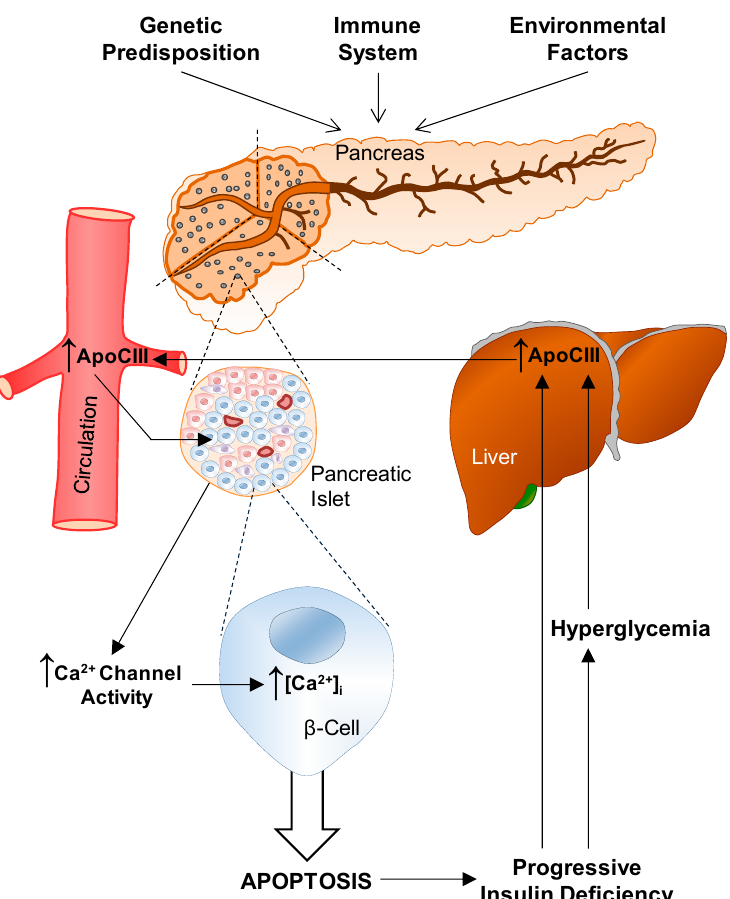
Figure 2. A schematic overview of factors involved in the development of type-1 diabetes (T1D). The background rests on three pillars: genetic predisposition, a dysfunctional immune system and environmental factors. The autoimmune attack on the pancreatic islet β -cells starts. ApoCIII increases the activity of voltage-gated Ca 2+ -channels, thereby increasing [Ca 2+ ] i resulting in apoptosis. The progressive decrease in insulin and rise in glucose in the blood diminish the inhibition of the apoCIII gene and the increase in apoCIII hyperactivates Ca 2+- channels, and a vicious circle is established.